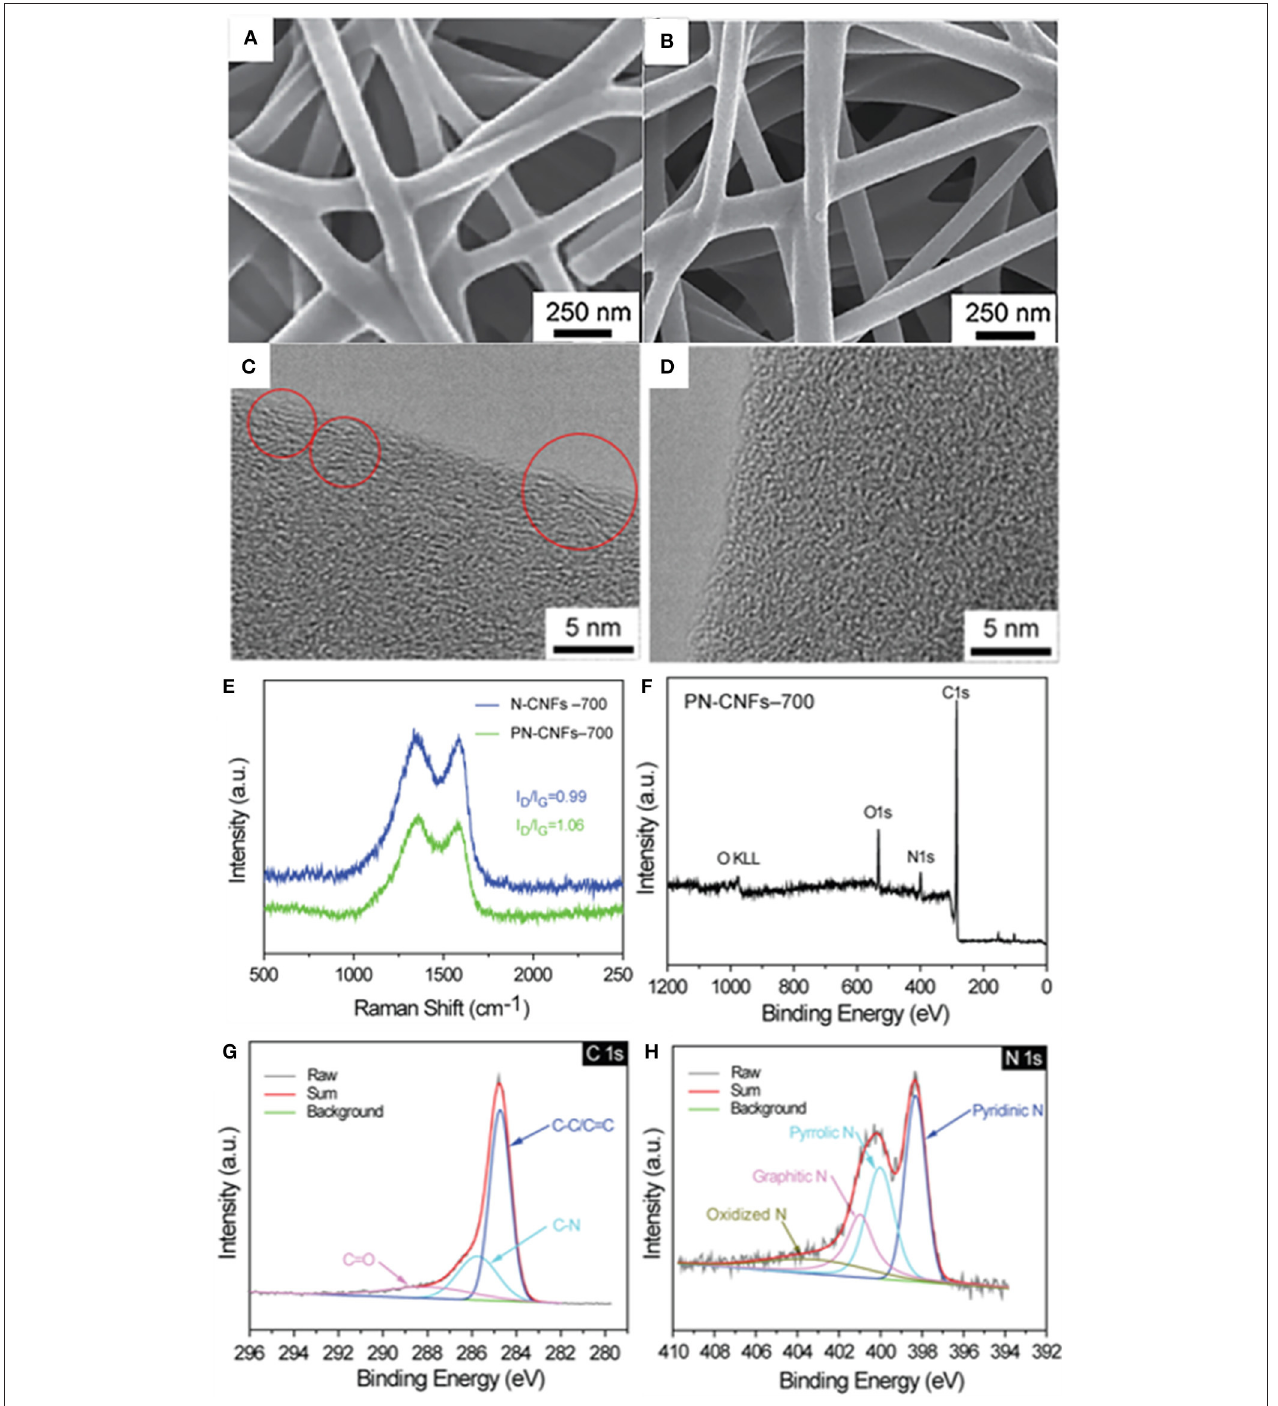
FIGURE 2 | SEM image of N–CFs-700 (A) and PN-CFs-700 (B) ; HRTEM image of PN-CFs-700 (C) and N-CFs-700 (D) ; Raman spectra of N-CFs-700 and PN-CFs-700 (E) . The XPS survey (F) and high resolution C1s (G) and N1S (H) spectra of PN-CFs-700.